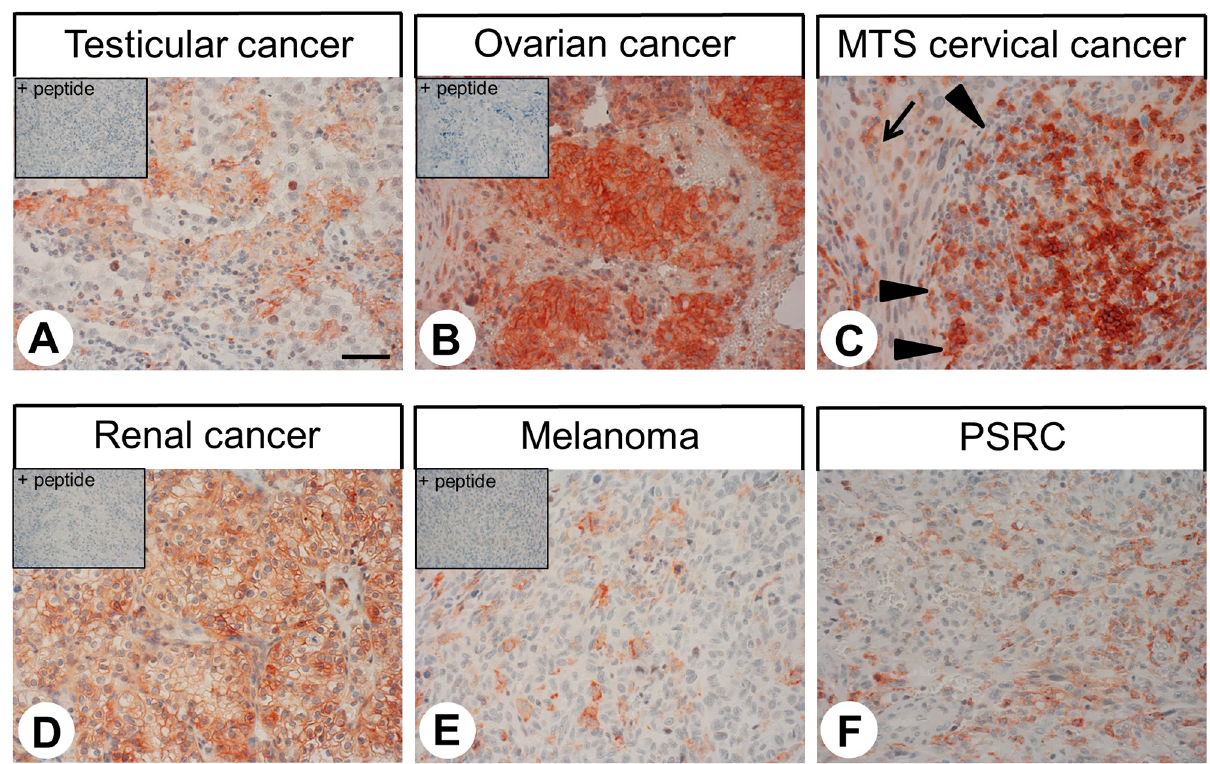
Fig 6. Immunohistochemical detection of C5aR1 localisation in human tumour entities (II). Immunohistochemical staining (red-brown colour), counterstaining with haematoxylin. Scale bar: 50 μ m (A-F). Insets in (A, B, D, E): for adsorption control, the anti-C5aR1 antibody {5227} was incubated with 10 μ g/ml of the peptide used for immunisations. Arrow in (C): tumour cells (lymph node metastasis of a cervical carcinoma); arrowheads in (C): lymph follicle. MTS: lymph node metastasis; PSRC: pleomorphic sarcoma.